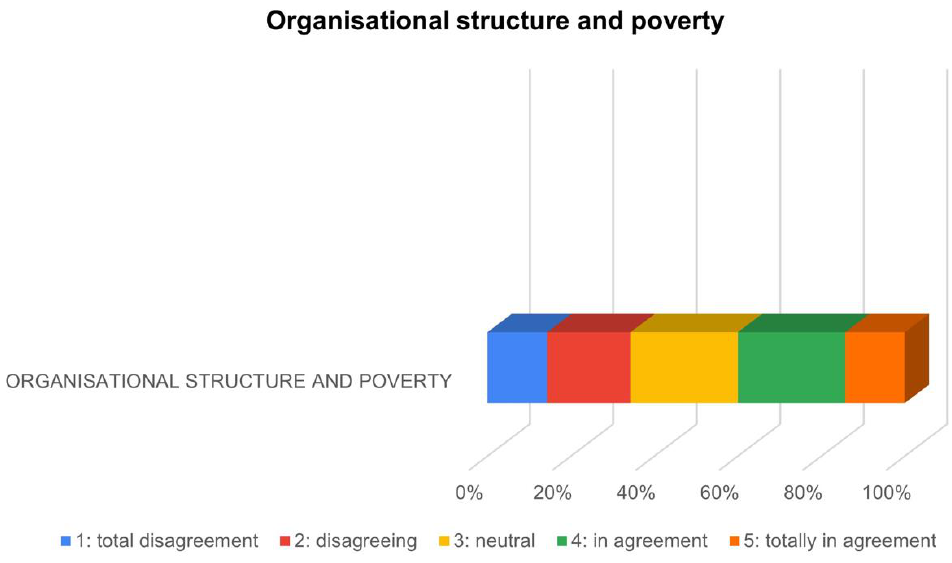
Figure 8. Organizational structure and poverty.